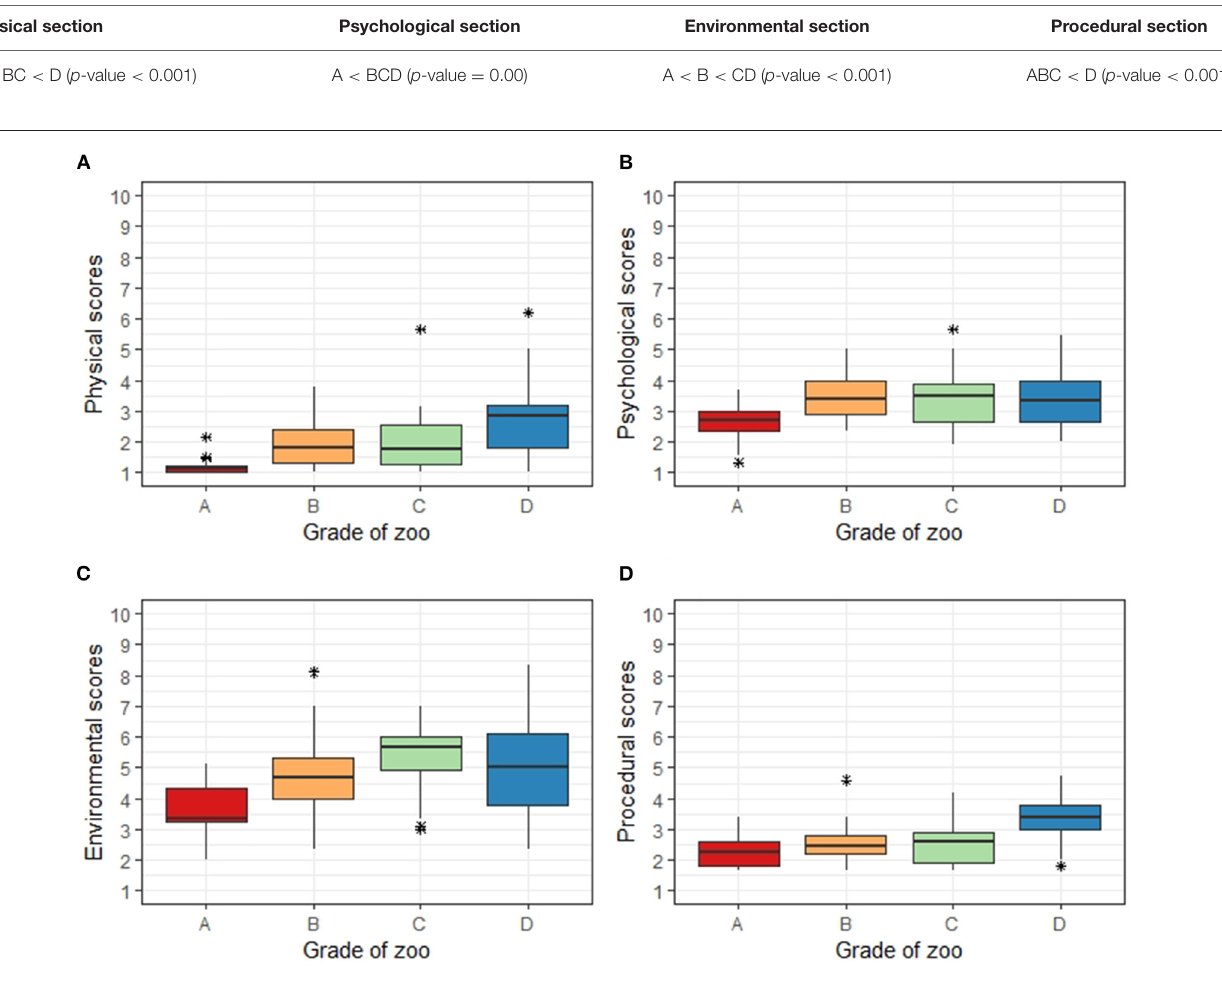
FIGURE 4 | Box-and-whisker plots of averaged modified Animal Welfare Assessment Grid (AWAG) scores of 11 species from 16 zoos in South Korea according to zoo levels. The AWAG scores were assessed from 1 to 10 points in the order of “very good” (1) to “worst” (10). Three groups of inspectors determined the scores for each animal and averaged the scores with very high inter-rater reliability. The zoo levels were defined as (A) (AZA-accredited zoos), (B) (Korean Association of Zoos & Aquariums-certified zoos), (C) (large petting zoos, > 50 species, > 1,000 individuals, > 3,000 m 2 ), or (D) (small petting zoos). For each plot, the color represents the zoo levels, the box represents the interquartile range (IQR), the whiskers represent 1.5 times the IQR range, the bold horizontal line represents the median, and each asterisk represents the outlier